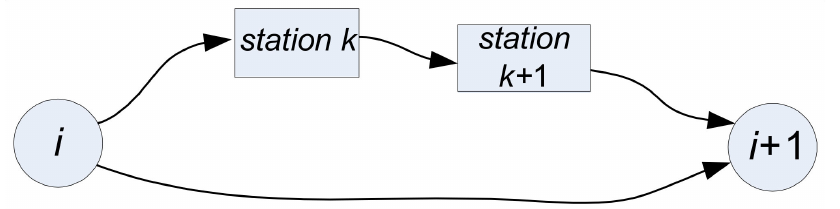
Figure 3. There are two fueling stations on a potential road section between the i -th and the i +1-th hub. Basic case.